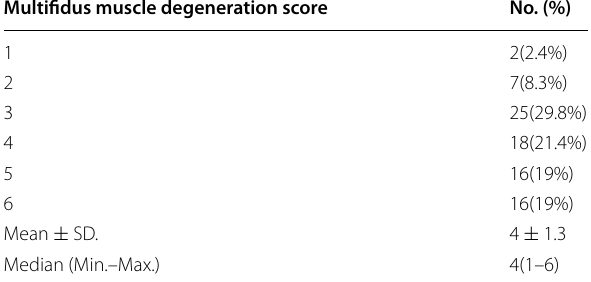
Table 2 Distribution of the studied cases according to multifidus muscle degeneration score measured by manual calculation (n 84) =